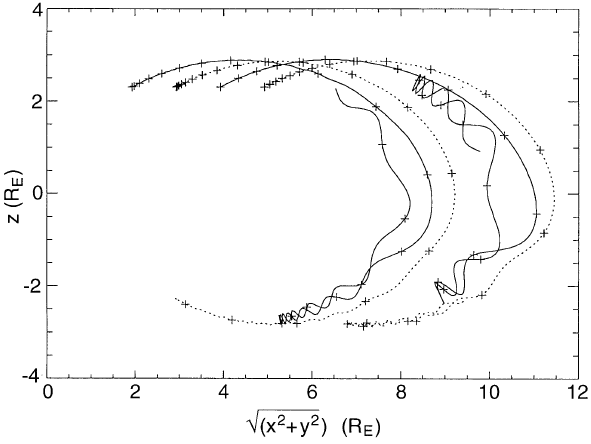
Fig. 6. The trajectories of ions as projected onto the 2125-MLT meridian plane. Ions are launched along the 68 ° MLAT magnetic field line. All but the 3-keV, 90 ° trajectory are shifted to the right for legibility by 1,2, and 3 R (cid:69) for 300-eV, 90 ° ; 3-keV, 180 ° ; 300-eV, 180 ° ions, respectively. 300-eV ion trajectories are represented by dotted , 3-keV ions by continuous curves